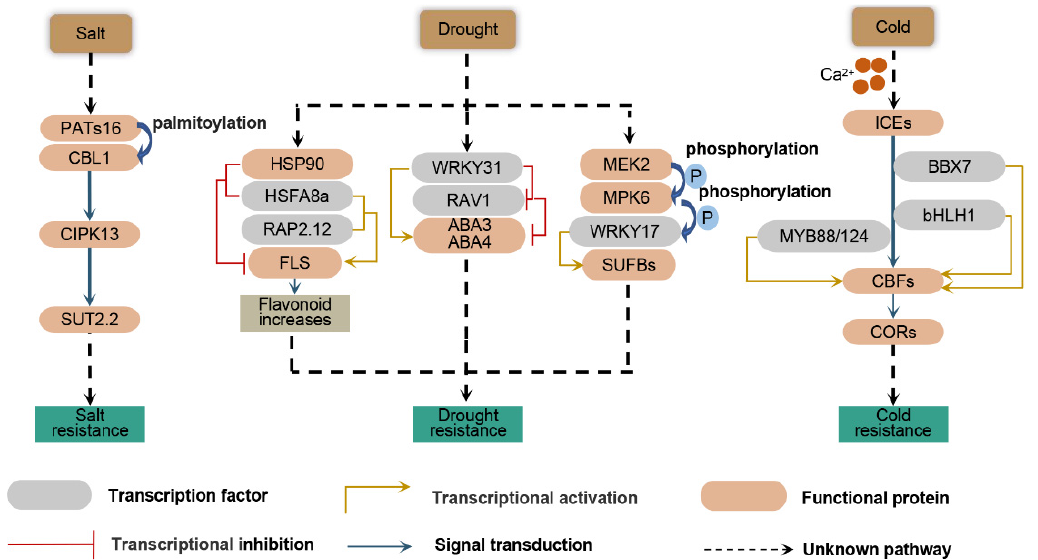
Figure 1. Summary of the role of the control network and signal transduction-dependent pathways in responses to biotic stress and abiotic stress in apple. Under salt stress, MdPAT16 participates in the regulation of the MdCIPK13-regulated salt stress response and sugar accumulation through the palmitoylation of MdCBL1. Under drought stress, the MdHSP90-MdHSFA8a complex dissociates, and the released MdHSFA8a interacts with the AP2/ERF family transcription factor MdRAP2.12, thereby activating the activities of the related structural genes in the downstream flavonoid path- way. MdWRKY31 participates in the ABA signaling pathway by inhibiting the transcriptional ac- tivity of MdRAV1 to enhance the transcriptional activity of MdABI3 and MdABI4. The MdMEK2- MdMPK6-MdWRKY17-MdSUFB signaling pathway stabilizes the chlorophyll content in the leaves of apple plants under moderate drought stress. Cold stress mediated by ICE-CBF-COR is induced by transcription factors such as BBX, MYB, and bHLH. PAT16: protein palmitoyl transferase 16;